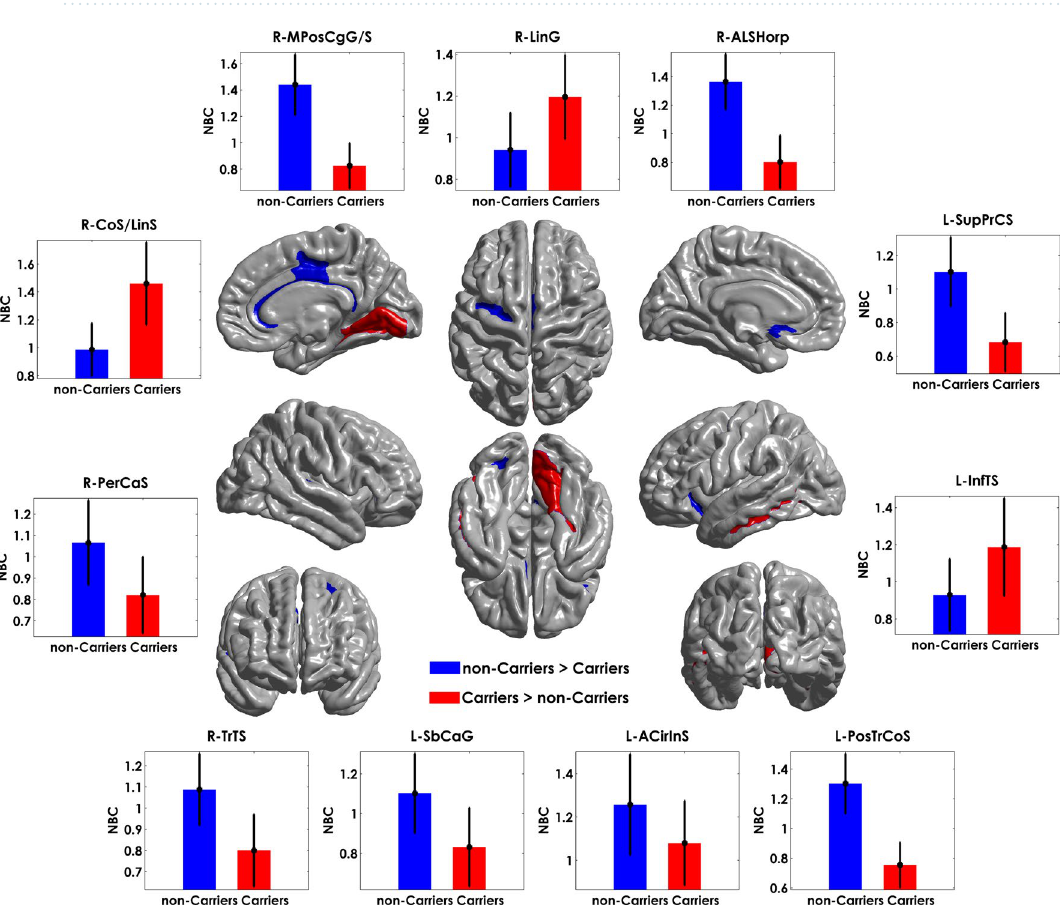
Figure 6. Significant differences between groups based on NBC. The bar heights represent the mean NBC values for each group, and the error bars the standard deviations. R: right hemisphere, L: left hemisphere. The regions were mapped onto the cortical surfaces using the BrainNet Viewer package (http://www.nitrc .org/proje